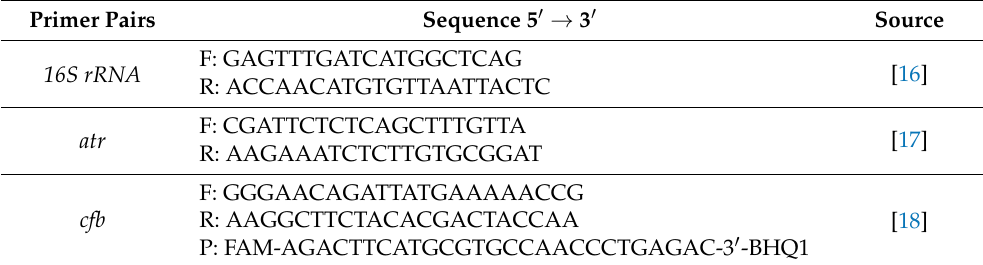
Table 1. Sequences of primer pairs and probe specific for S. agalactiae (GBS) used in this